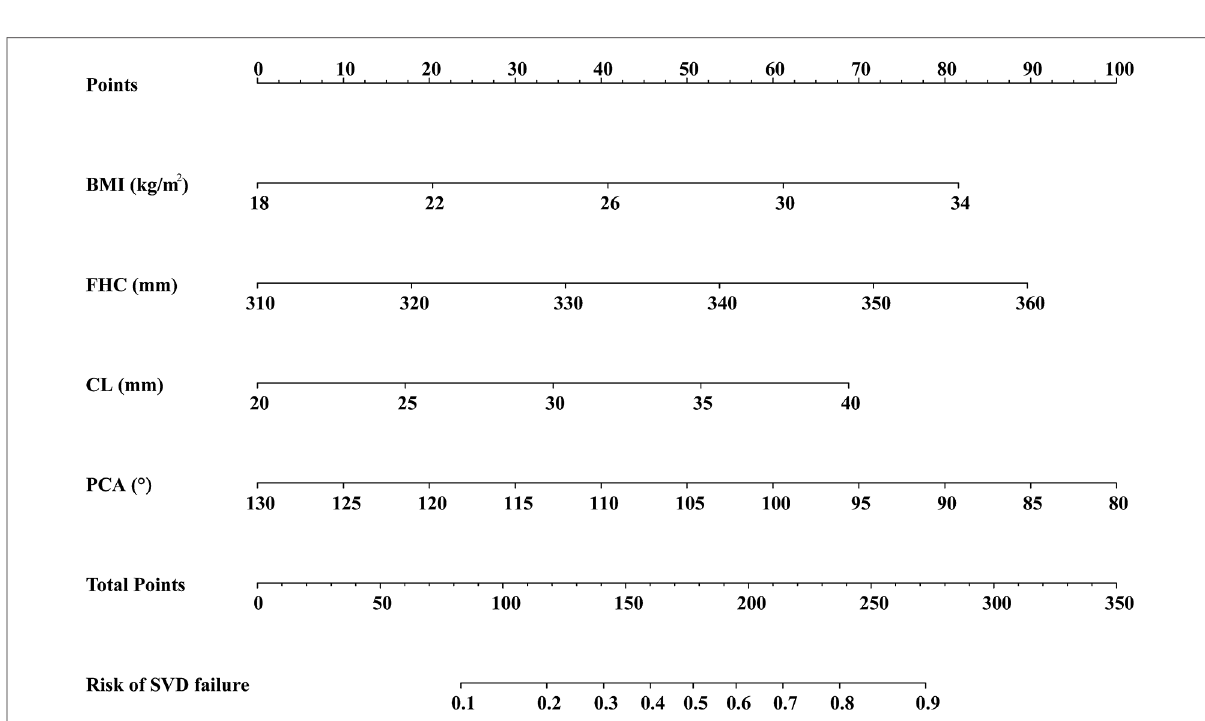
FIGURE 4 Nomogram for estimating the likelihood of SVD failure based on the multivariate logistic regression analysis. The predictors included in the nomogram are BMI, FHC, CL, and PCA. SVD, spontaneous vaginal delivery; BMI, body mass index; FHC, fetal head circumference; CL, cervical length; PCA, posterior cervical angle.